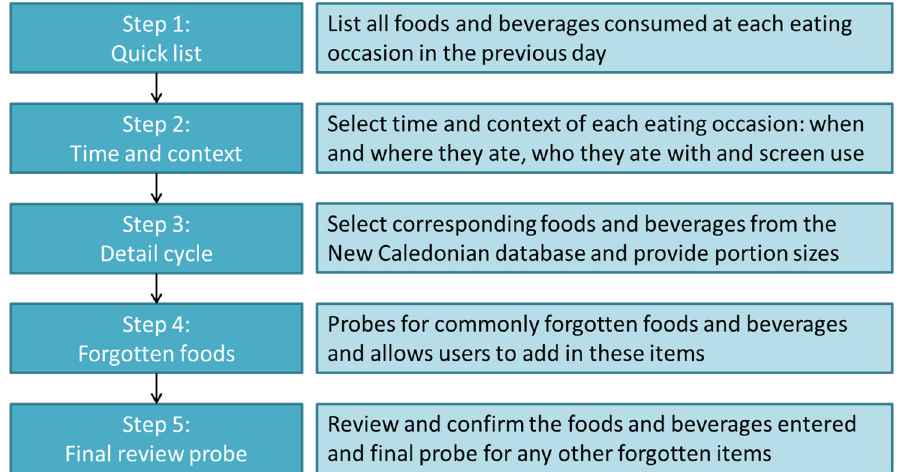
Figure 1. The multiple-pass 24-h recall process for the iRecall.24 app.